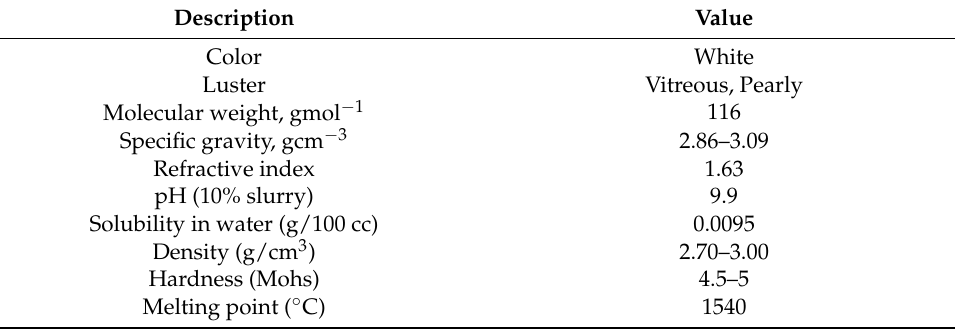
Table 2. The physical and chemical properties of wollastonite.